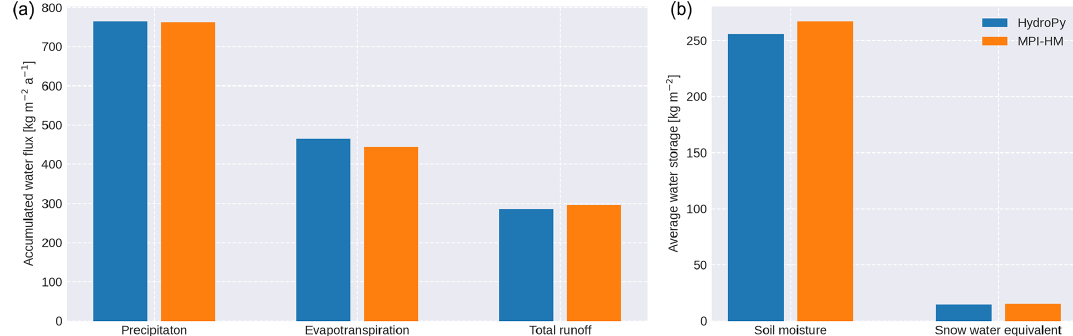
Figure 11. Land surface water fluxes (a) and storage states (b) averaged over the simulation period for HydroPy (blue) and MPI-HM